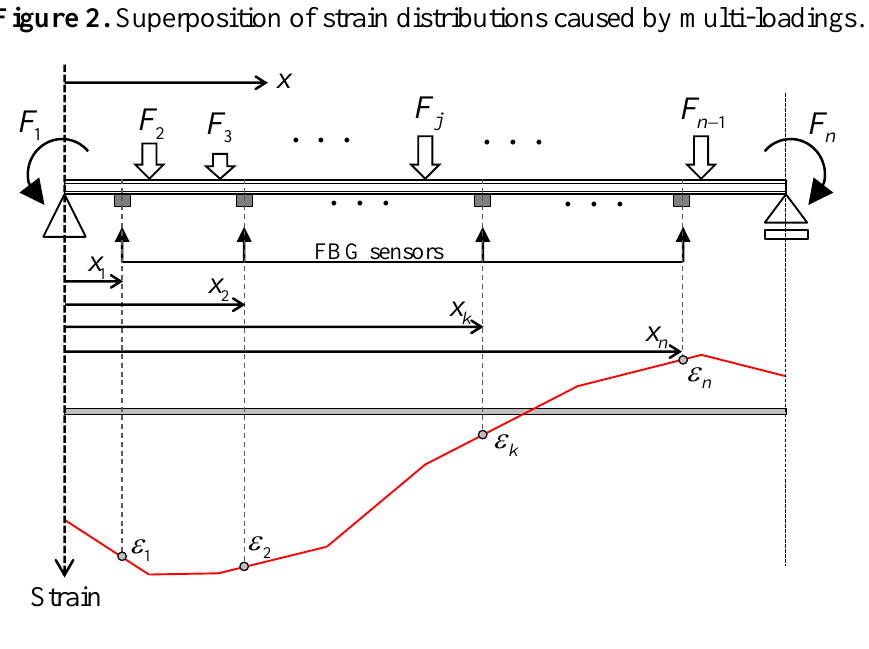
Figure 2. Superposition of strain distributions caused by